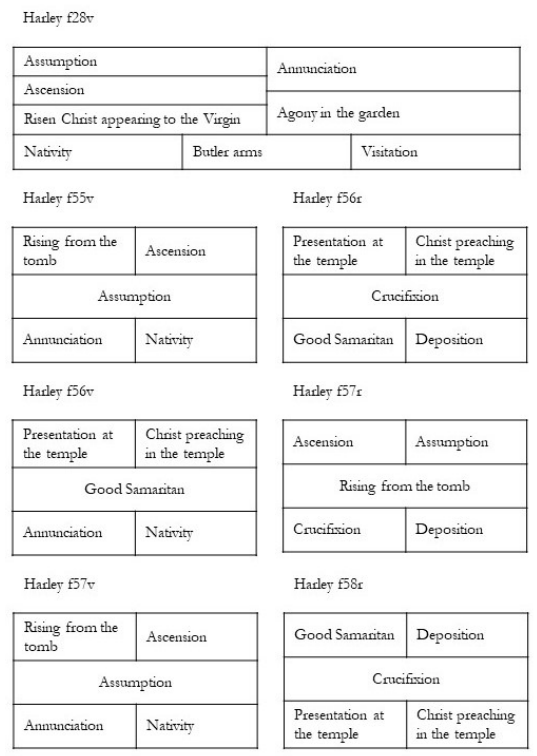
Figure 5. Layout of the pictorial cycles in the Hours of the Earls of Ormond.